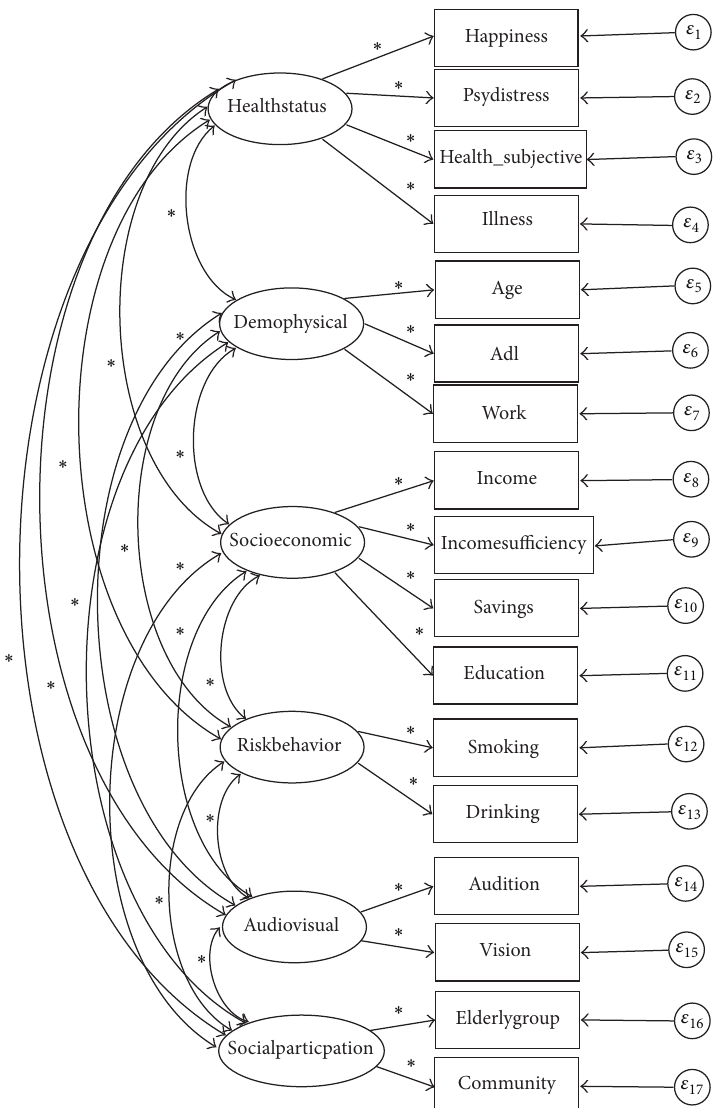
Figure 1: Hypothesized active ageing determinant factors model for female older persons in Thailand. Source: figure is constructed from Haque et al.’s study